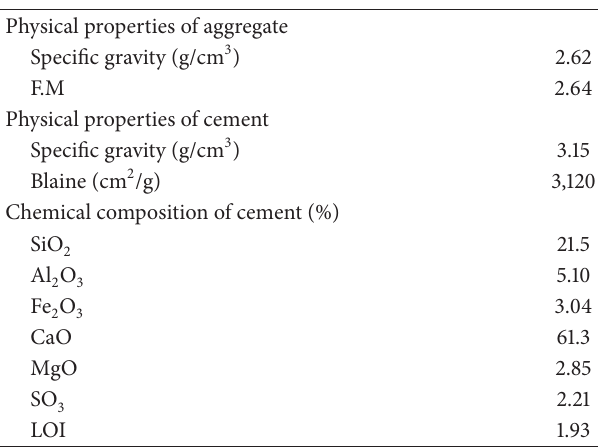
Table 2: Physical properties of cement and sand.